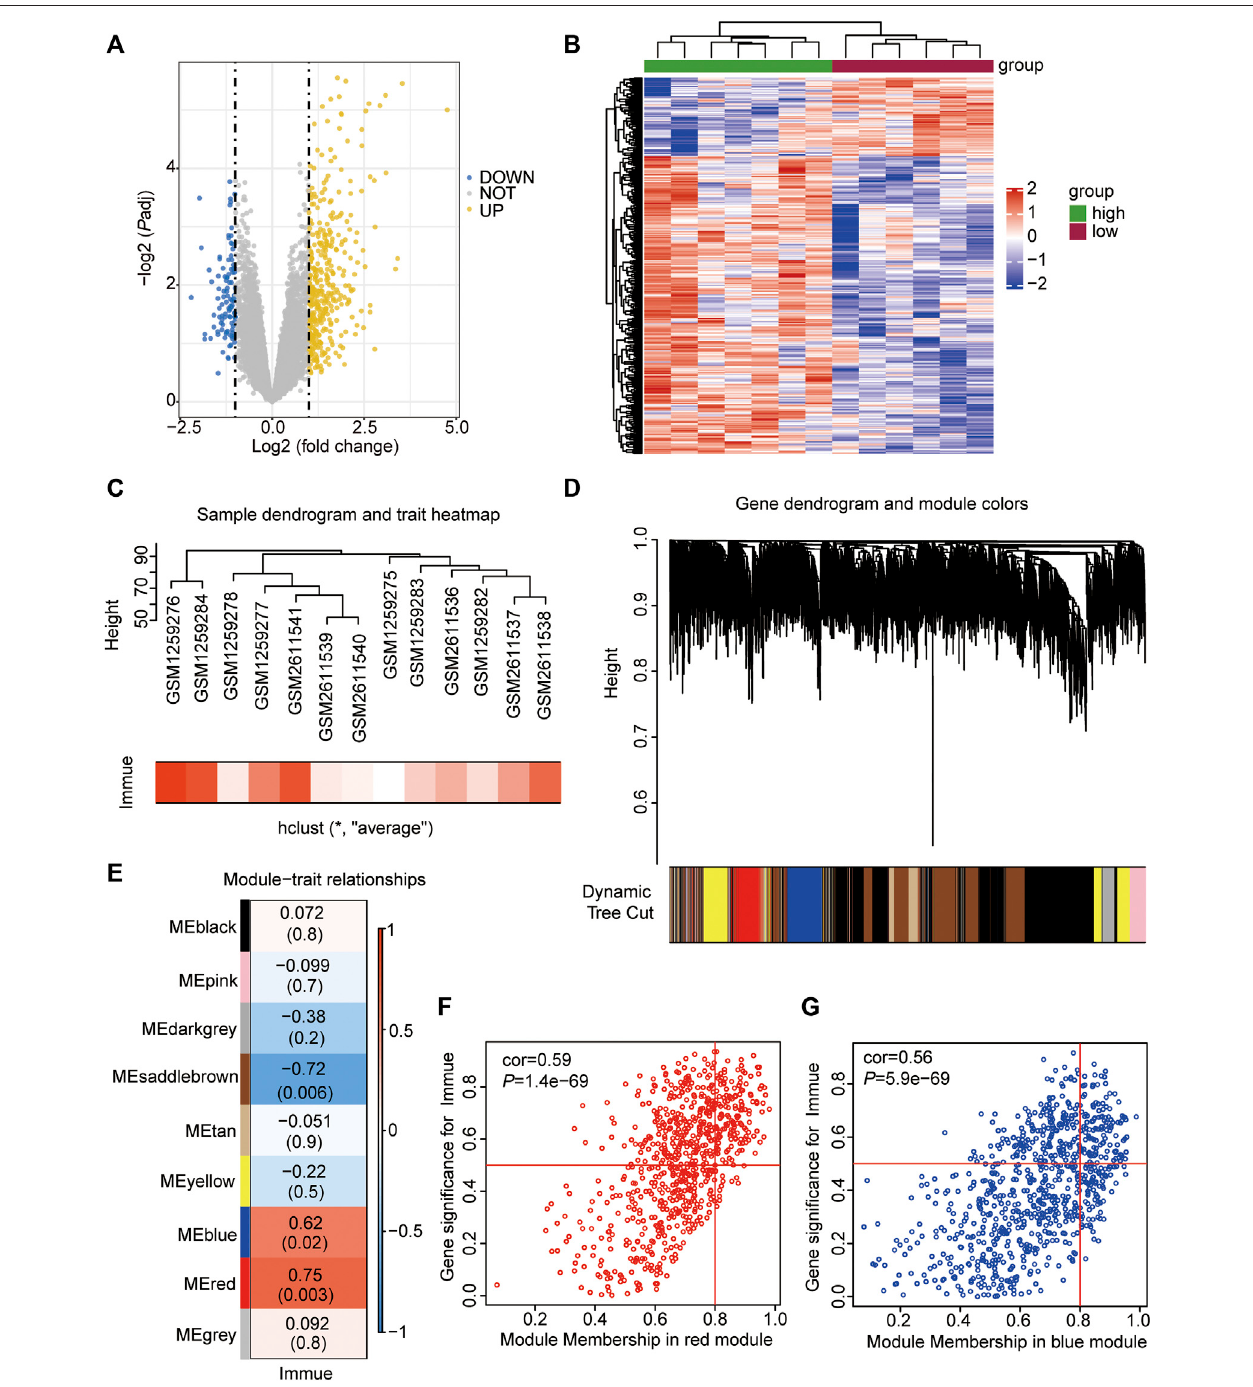
FIGURE 2 | Immune in fi ltration-related DEGs and WGCNA analyses. (A) Volcano Plot showing the DEGs in the high- vs. low-immune subgroups. The yellow dots represent up-regulated genes, the blue dots represent down-regulated genes, and the gray dots represent genes with no signi fi cant difference. DEGs were identi fi ed withthethresholdofadjust p -value < 0.05andFoldchange > 2. (B) HeatmapshowingtheDEGsinthehigh-vs.low-immunesubgroups.Theabscissashowedthepatient ID,andtheordinateshowedgeneswithdifferentexpression.Theredrepresentsdown-regulatedgenes,whilethebluerepresentsup-regulatedgenes. (C) Sample dendrogram and trait heatmap showing the ATAAD GEO samples clustering. The red represents samples with high immune, the white represents samples with low immune. (D) Gene dendrogram and module colors showing the gene clustering. The different color represents different expressional module. (E) Heatmap showing the co-relationship of different modules and immunophenotype. (F) Scatter plot showing the correlation between immunophenotype and genes in red module. (G) Scatter plot showing the correlation between immunophenotype and genes in blue module.